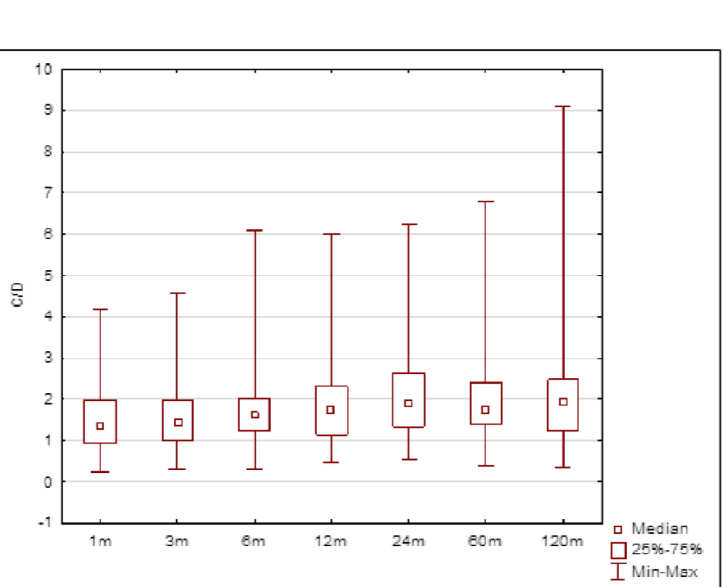
Figure 3. The creatinine concentration from the most recent appointment between the C/D ratio <1.63 ( A ) and ≥1.63 ( B ) groups. Significant differences in the creatinine concentration from the most recent appointment between the C/D ratio <1.63 and ≥1.63 groups ( p = 0.02, Mann-Whitney U test).